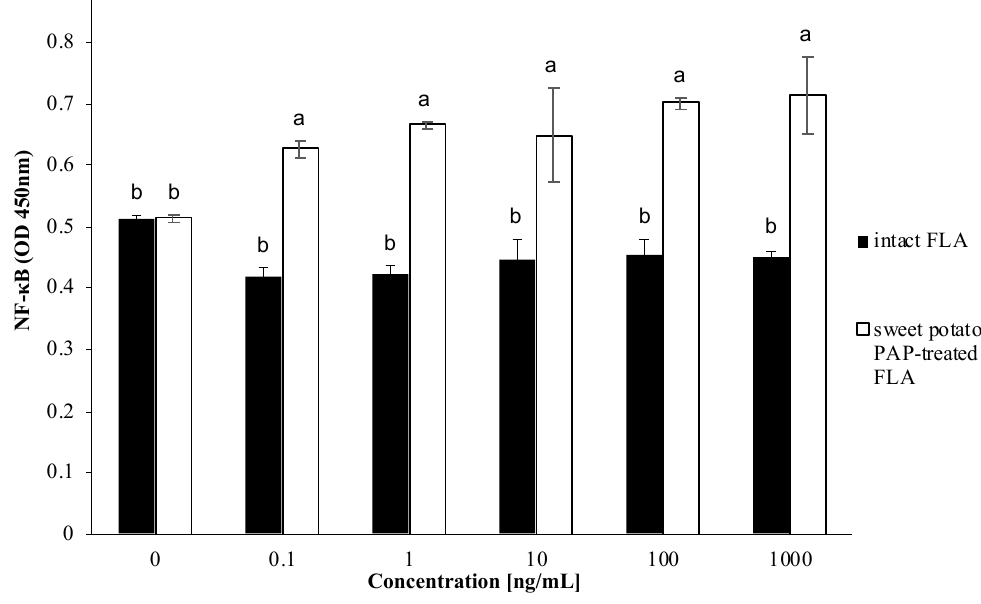
Figure 4. Effect of sweet potato PAP on PA FLA-induced NF-κB activation in A549 cells. A549 cells were initially seeded onto 96-well plates at a density of 1.5×10 4 cells per well and cultured to 80% confluency at 37°C in a 5% CO incubator. Various concentrations of FLA (0, 0.1, 1, 10, 100, 2 1,000 ng/mL) were treated with 1 μL of sweet potato PAP (11.6 μg) for 6 h. Then, enzyme-treated FLA and intact FLA at each concentration were applied to the cells for 12 h. The level of NF-κB was assayed at OD 450 nm using NF-κB p65 (Total) InstantOne ELISA Kit. The data were ex - pressed as the mean and standard errors from three experiments. PAP, purple acid phosphatase; PA FLA, Pseudomonas aeruginosa flagellin; NF- κB, nuclear factor kappa- light-chain-enhancer of activated B; OD, optical density; ELISA, enzyme-linked immunosorbent assay. a,b Means lacking common letters differ significantly